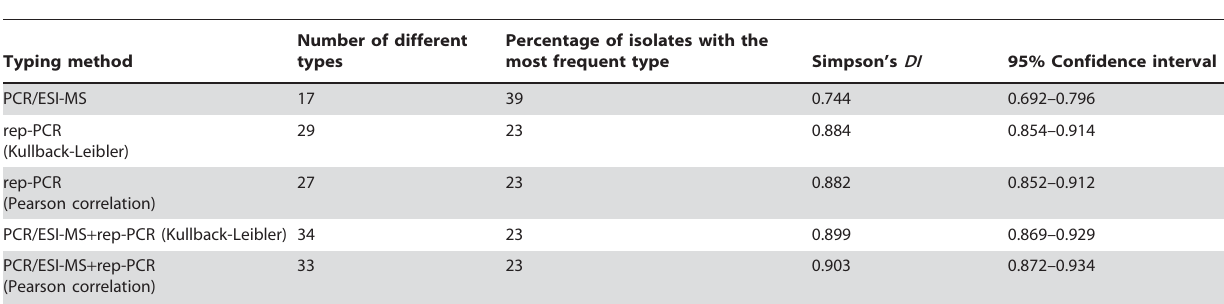
Table 2. Simpson’s Diversity index ( DI ) of PCR/ESI-MS, rep-PCR and the combination of PCR/ESI-MS and rep-PCR.